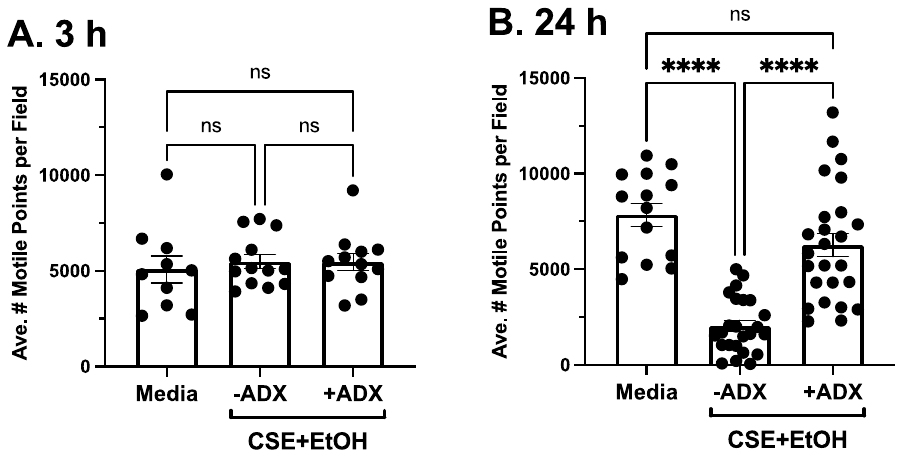
Figure 5. ADX-102 and loss of tracheal epithelial cell cilia. Ciliated MTECs were treated with a